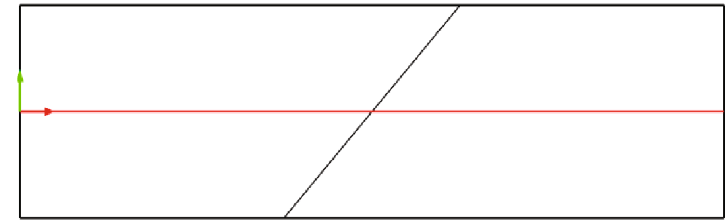
Figure 10: The view of the line at the middle of the channel.